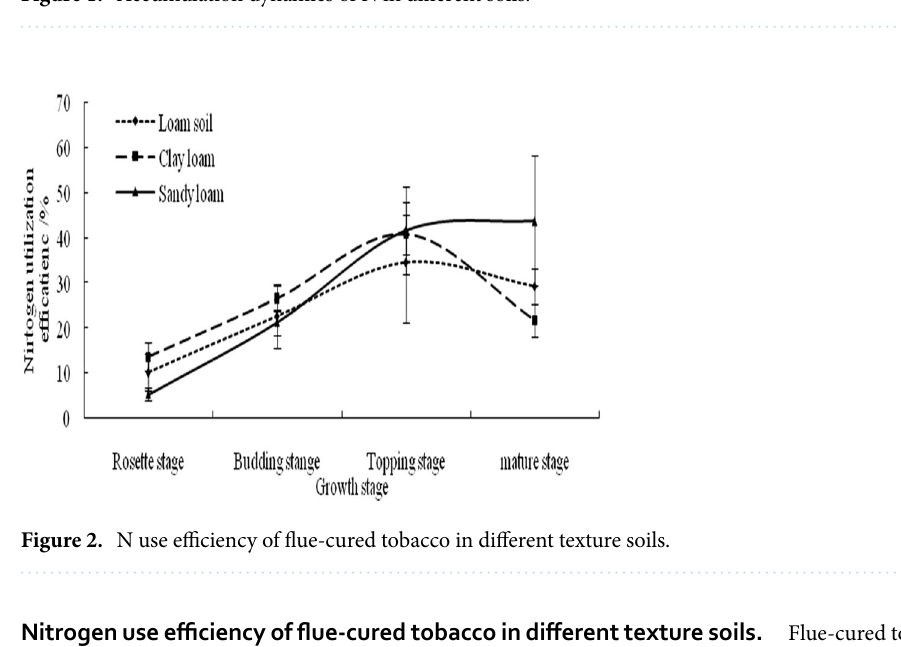
Figure 1. Accumulation dynamics of N in different soils.